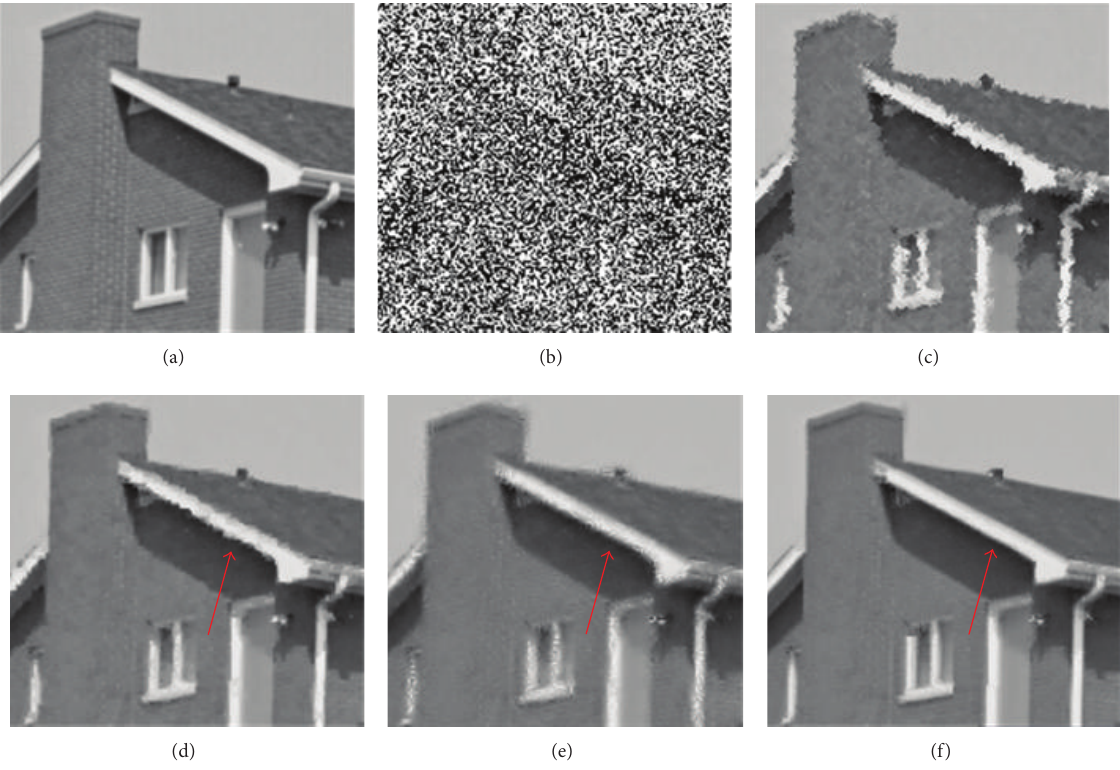
Figure 9: Reconstructed House images from 70% salt and pepper impulse noise. (a) Noise-free image, (b) noisy image, (c)–(f) reconstructed images using AMF, TV-ND, Wavelet-ND, and PANO-ND, respectively.